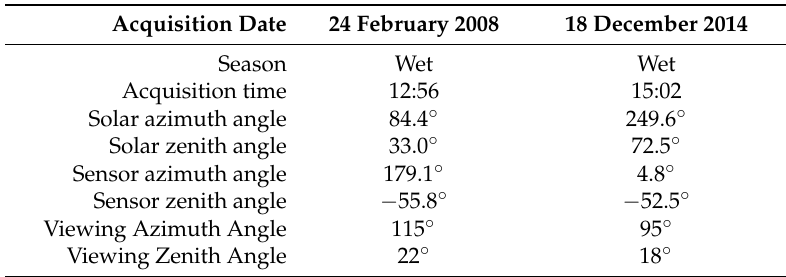
Table 3. Properties of the selected CHRIS/PROBA